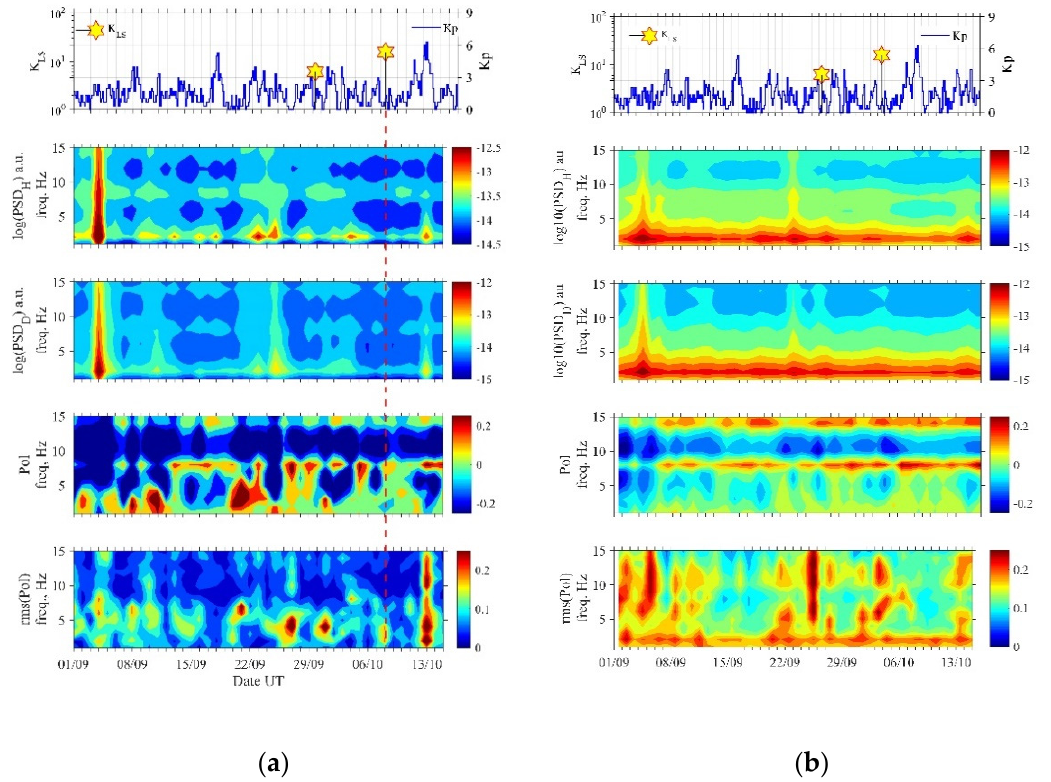
Figure 9. ( a ) Temporal evolution of magnetic ( K p ) and seismic activity ( K LS ) (top panel), spectra (horizontal H and D magnetic fields) (second and third panels), polarization (fourth panel) and its dispersion (bottom panel). Time interval is local nighttime (LT = 3–5 h). ( b ) The same as ( a ), but for full days.